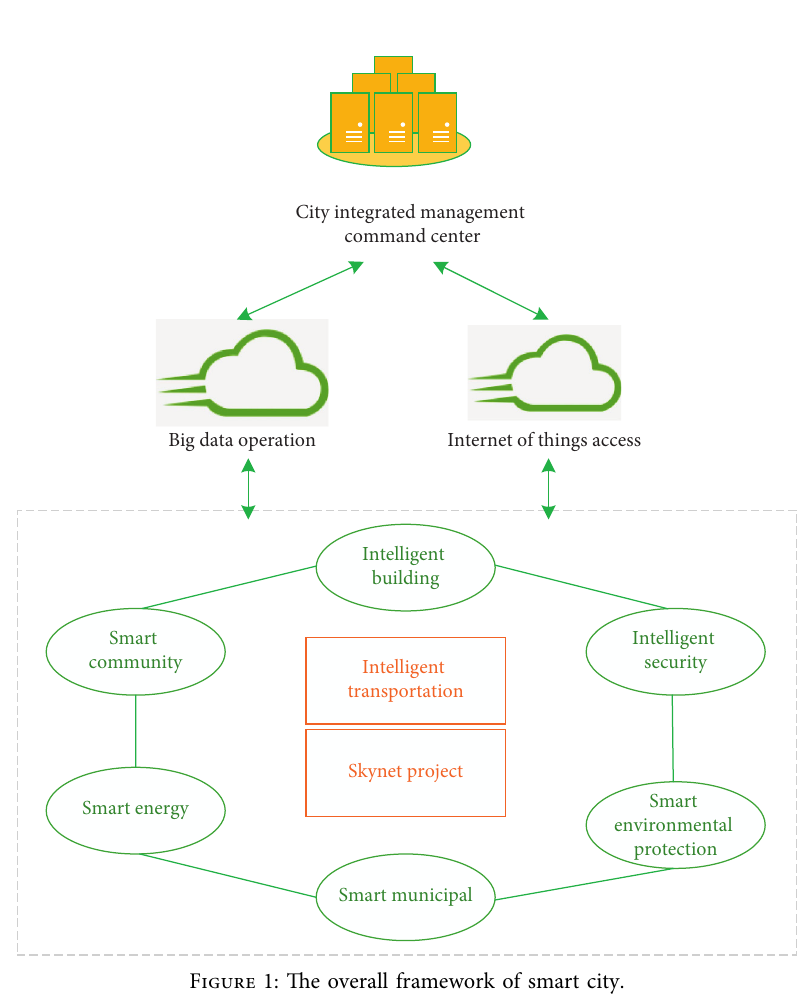
Figure 1: The overall framework of smart city.